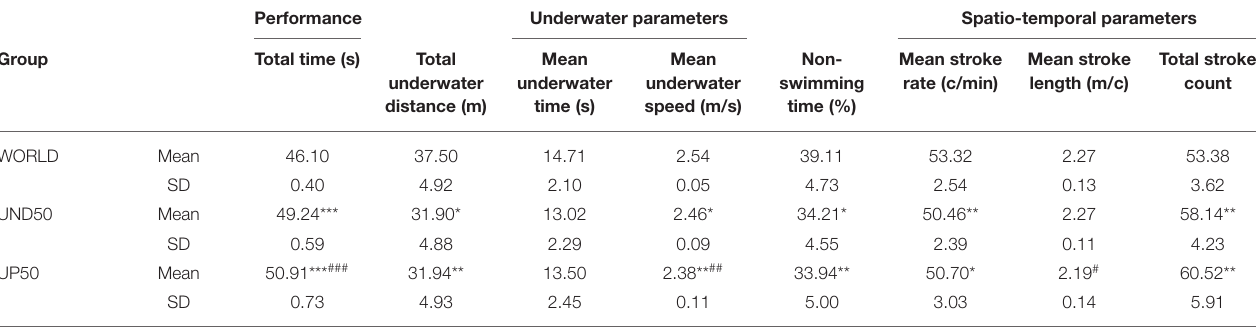
TABLE 1 | Comparison of mean ± SD for performance, underwater and spatio-temporal parameters among the world finalists (WORLD) vs. French swimmers under 50s (UND50) vs. French swimmers upper to 50s (UP50) during the 100m freestyle.